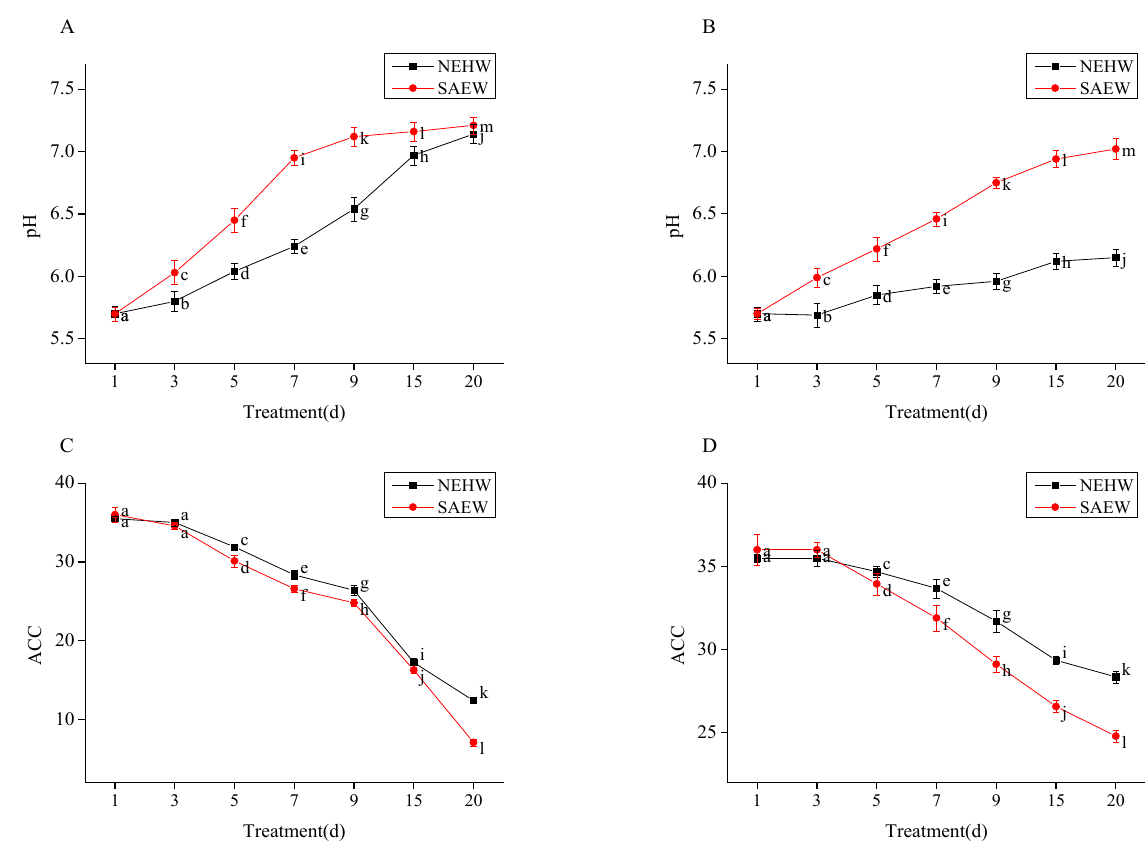
Figure 4. The changes of pH and ACC of NEHW and SAEW during 20 days of storage in open containers without avoiding light and sealed while avoiding light. ( A ), ( C ) are the changes of pH and ACC in open containers without avoiding light, respectively; ( B ), ( D ) are the changes of pH and ACC under the condition of sealed and avoiding light, respectively. The NEHW initial pH is 5.7 and ACC is 35.5; the SAEW initial pH is 5.7 and ACC is 36. ACC is the abbreviation for available chlorine concentration. All treatments and determinations were performed in triplicate. The different letters indicate significant differences ( p < 0.05). Values are the means of three replicated measurements ± standard deviation (SD).